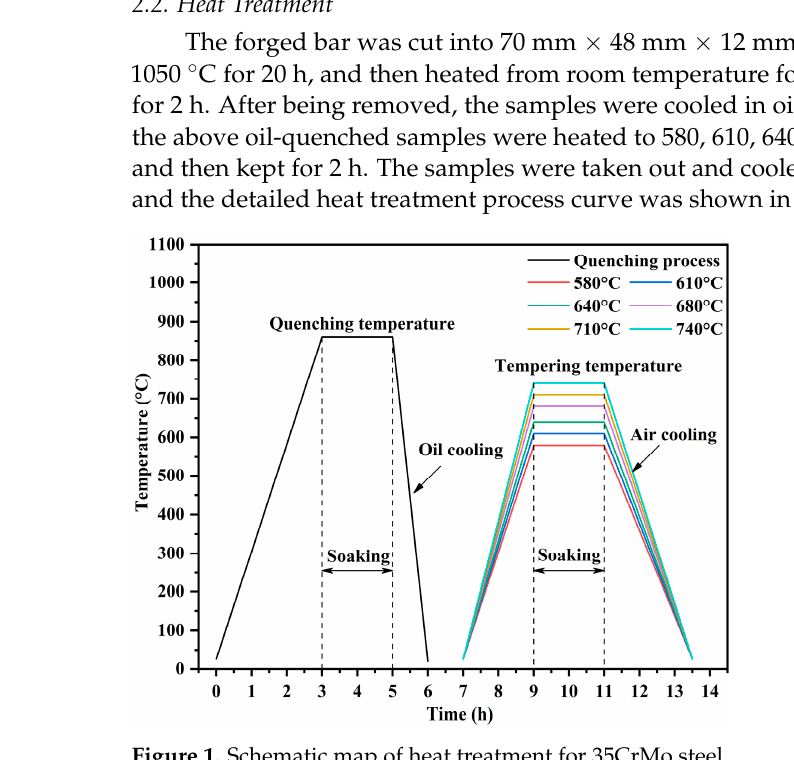
Figure 1. Schematic map of heat treatment for 35CrMo steel.